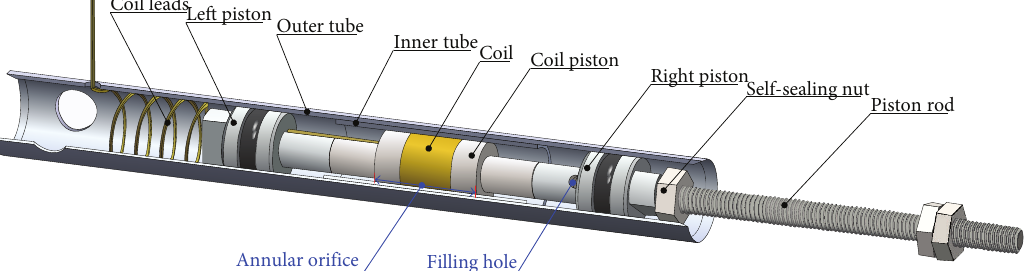
Figure 6: MR damper prototype cross-section.